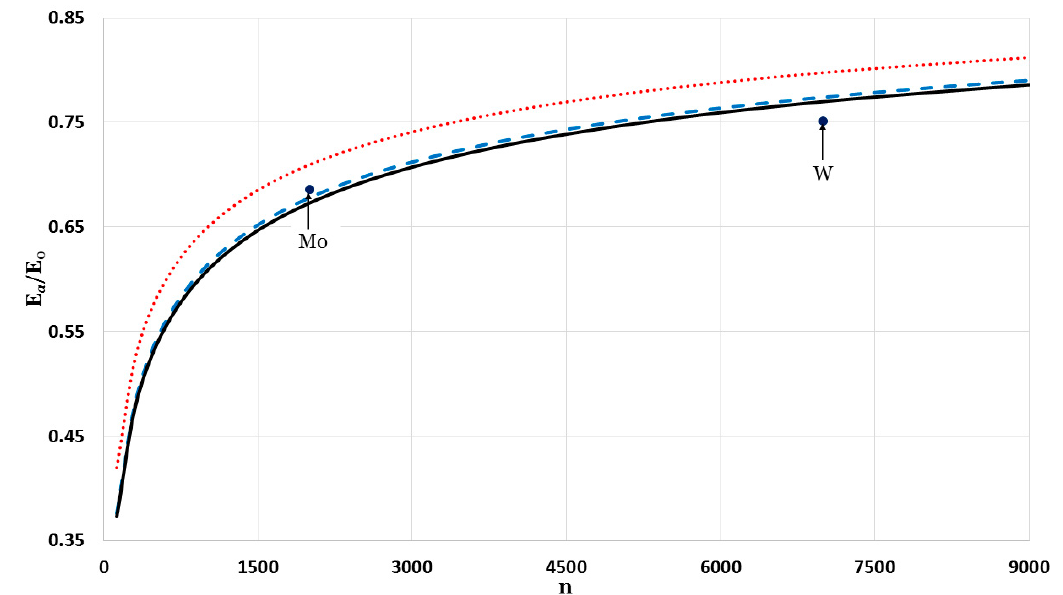
Figure 15. The variation of the relative cohesive energy as function of the number of atoms (where m = 3 and α = 2.1) for di ff erent cubic structures of nanoparticles: A body-centered cubic structure (black solid line), a face-centered cubic structure (blue dashed line), and a simple cubic structure (the red dotted line). The experimental values [23,24] are denoted by dark blue circles.